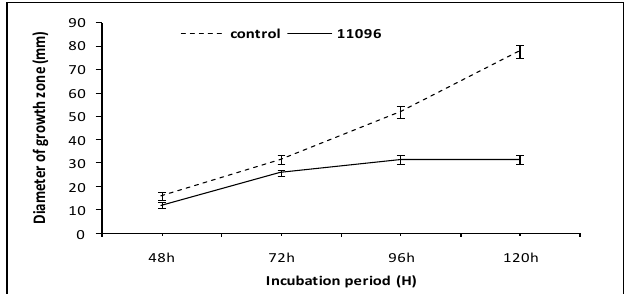
Figure 5. Effect of volatile secondary metabolites of Bga 11096 on growth rate of R. solani. Data are expressed as mean of three replicates ± SD.